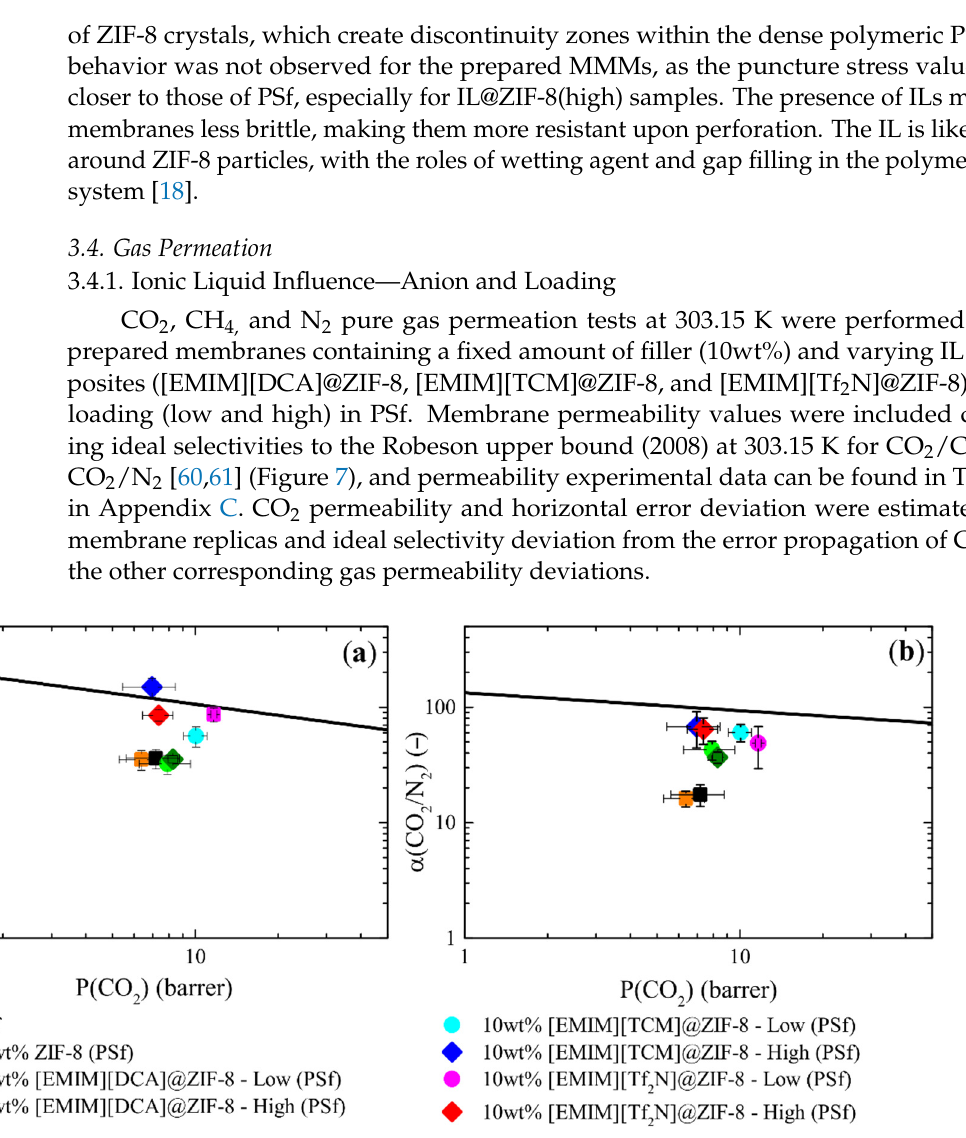
Figure 7. CO 2 pure gas permeation results at 303.15 K for PSf and several MMMs with fixed 10wt.% filler compared to Robeson upper bound (2008) at 303.15 K for ( a ) CO 2 /CH 4 and ( b ) CO 2 /N 2 ideal selectivities.